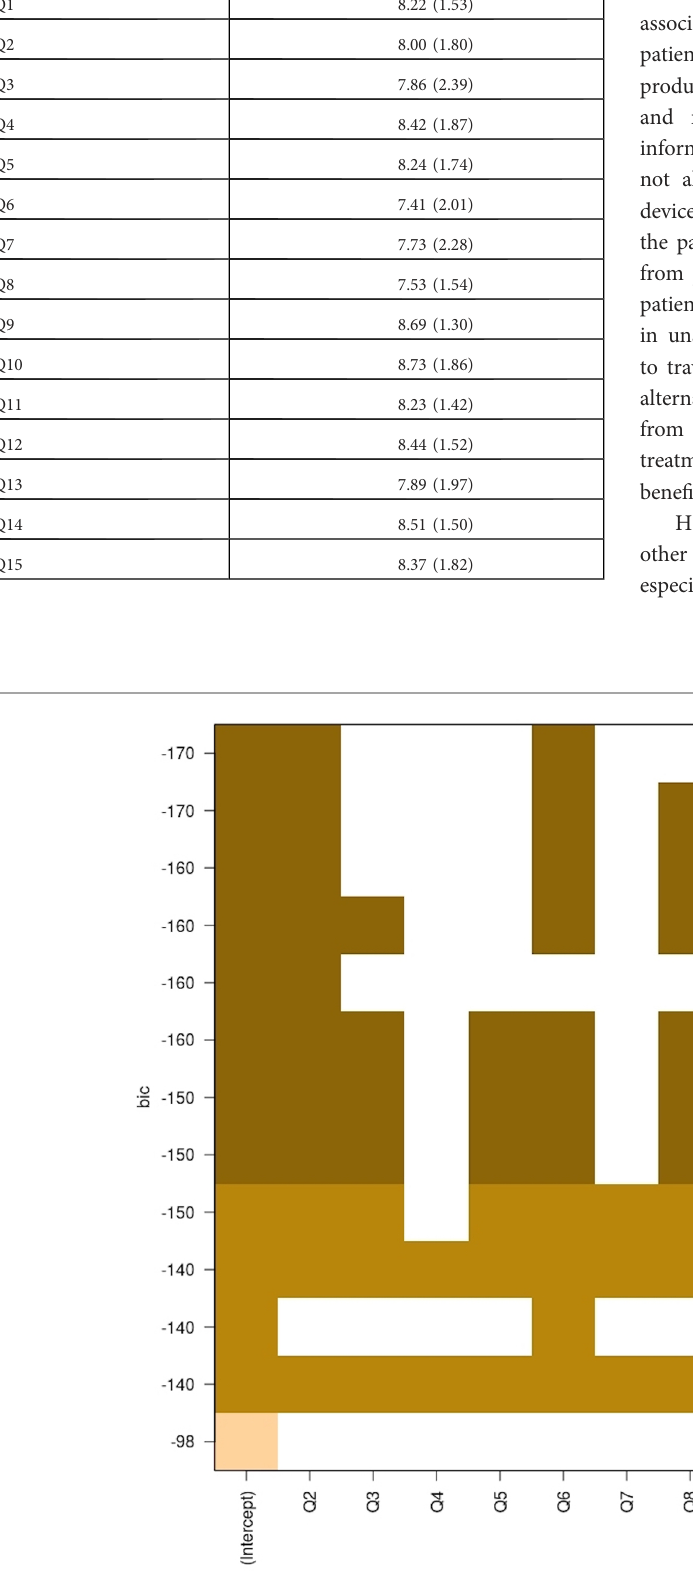
FIGURE 3 Bayesian criterion information, likelihood of predictive satisfaction